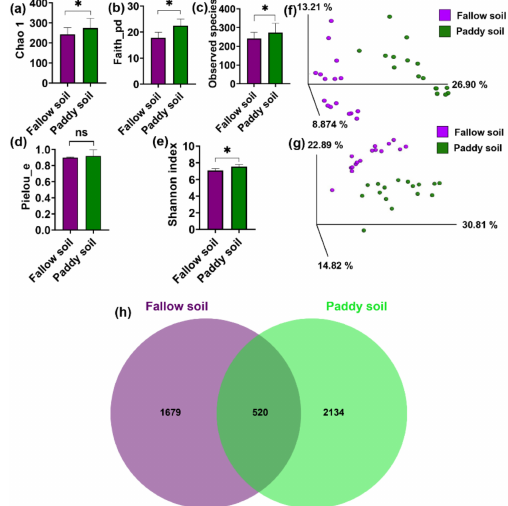
Figure 2. The α - and β -diversity of the bacterial community. ( a ) Chao 1; ( b ) Phylogenetic diversity; ( c ) OTU richness; ( d ) Evenness; and ( e ) Shannon index. Bars represent mean; error bars denote standard deviation; * (asterisks) over the bars represent significant differences ( p < 0.05), and ns over the bars represent non-significant differences. PCoA ordinations of the bacterial community were based on the Unweighted UniFrac distance ( f ) and Weighted UniFrac distance ( g ). PERMANOVA determined differences in bacterial beta diversity of the two kinds of soil, ( h ) Unique and shared OTUs in the two soil